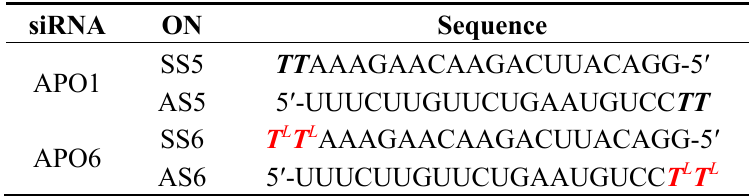
Table 3. Sequences of unmodified and T L -modified siRNAs targeting the ApoB mRNA. T L : L -threoninol-thymine monomer, T :